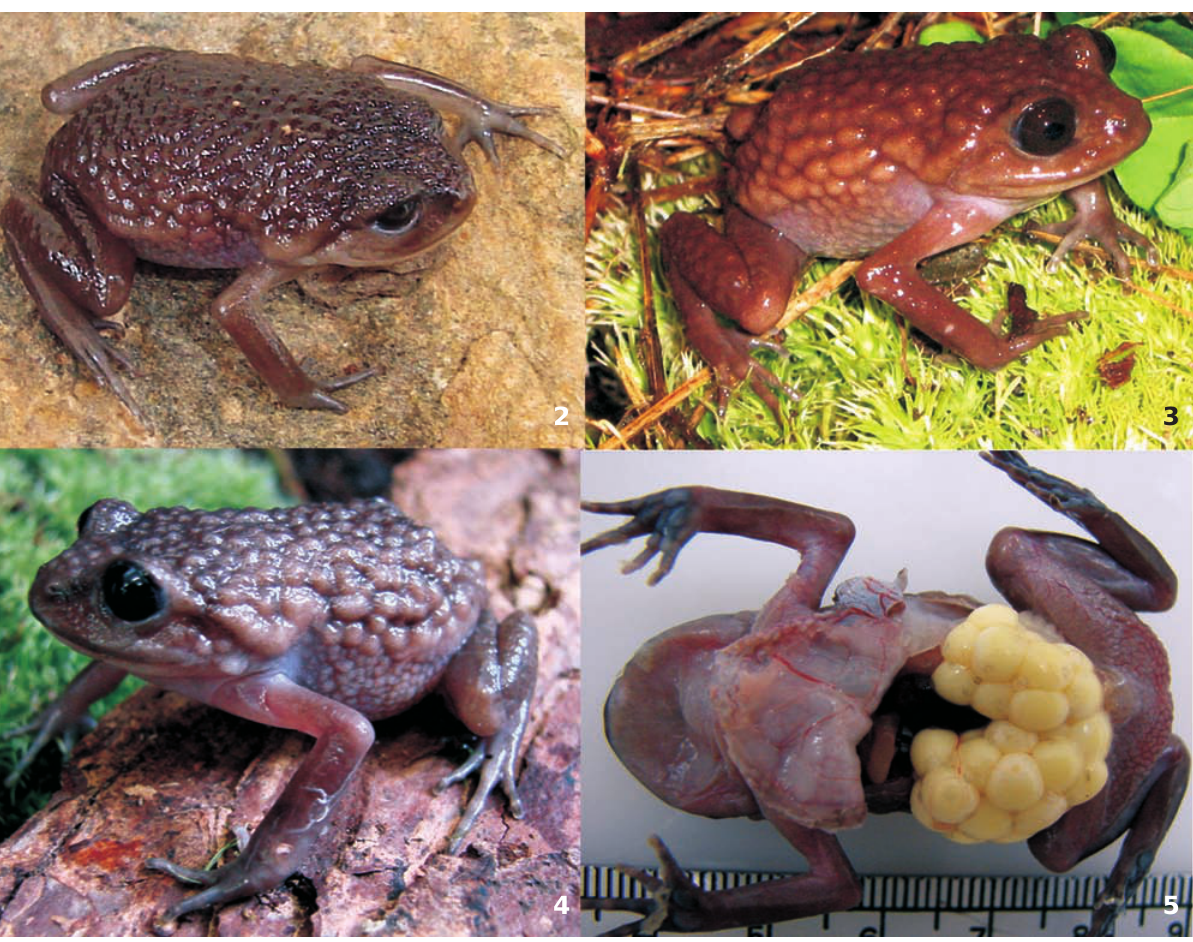
Figures 2-5. Images of specimens: (2) juvenile (3) male (4) female of H. luederwaldti registered in the Parque Estadual de Campos do Jordão, and (5) Coloration of oocytes.